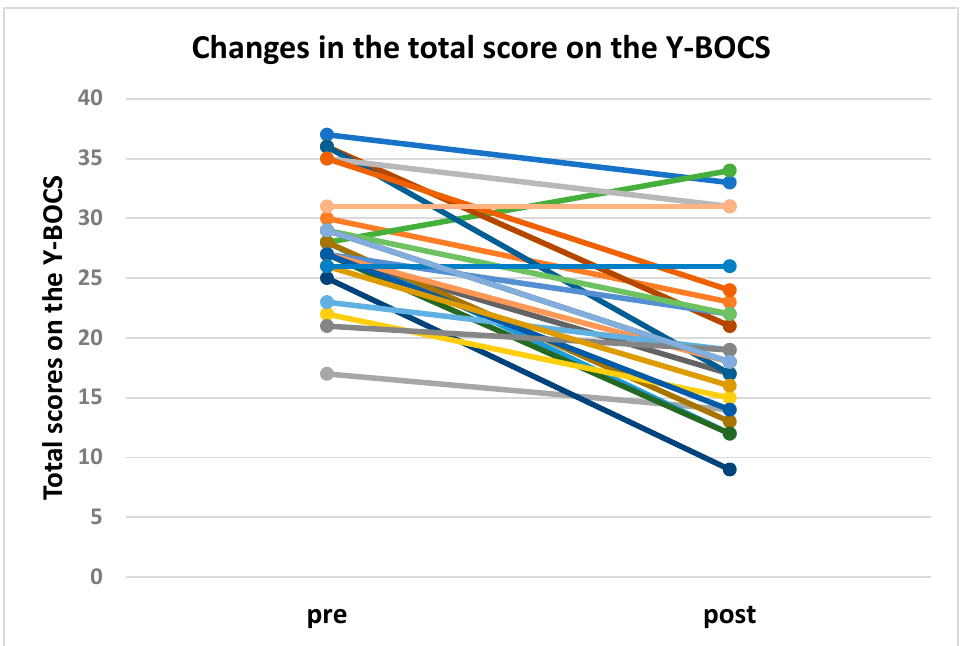
Figure 2. Changes in the total score on the Y-BOCS in patients with OCD following dTMS treatment combined with individualized exposure stimulation. Before and after a course of treatment, the mean scores (±S.D.) on the Y-BOCS of patients with OCD improved from 28.5 (5.0) to 20.0 (6.7). Each color in the line graph corresponds to a different case. The breakdown indicated that 23 of the 26 patients showed improvement in scores, 2 remained unchanged, and 1 worsened. Table 4. Percent changes of the total score on the Y-BOCS (whole, male vs. female, and on-medication vs. off-medication) following dTMS treatment combined with individualized exposure stimulation. Whole Males Females mean % changes of the Y-BOCS score